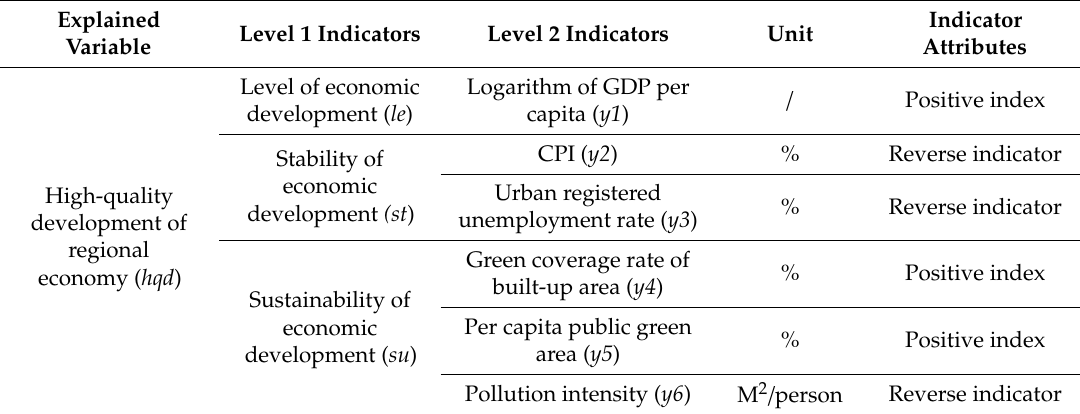
Table 1. Selection of indicators for the high-quality development of the regional